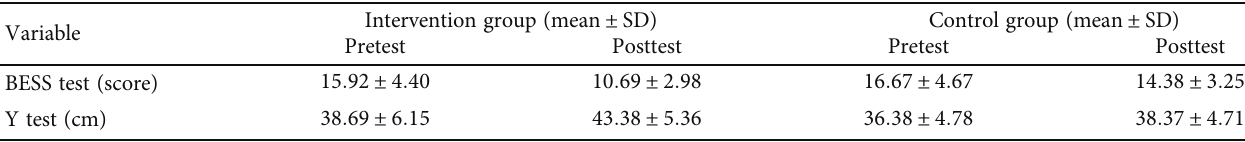
Table 2: Descriptive statistics of variables.